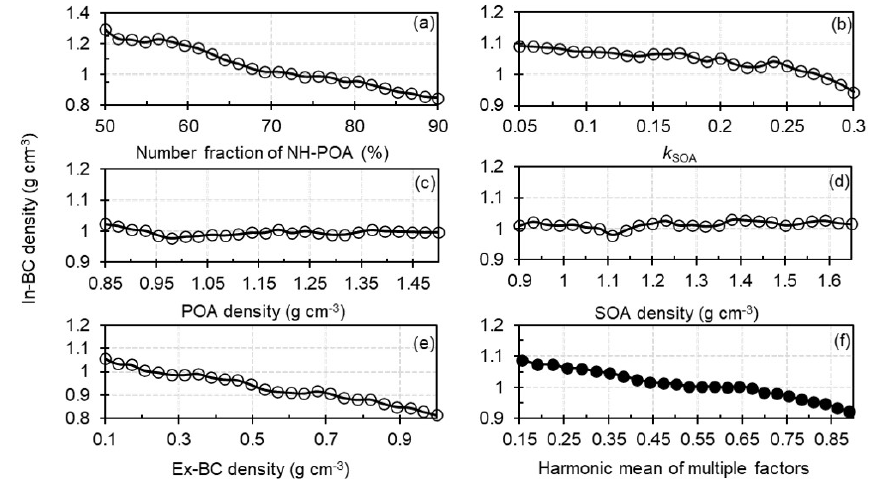
Figure 2. Sensitivity of the In-BC density to variations in the number fraction of nearly hydrophobic (NH) POA (a) , the hygroscopic parameter of SOA (b) , the POA density (c) , the SOA density (d) , the externally mixed BC density (e) , and the harmonic mean of multiple factors (f)